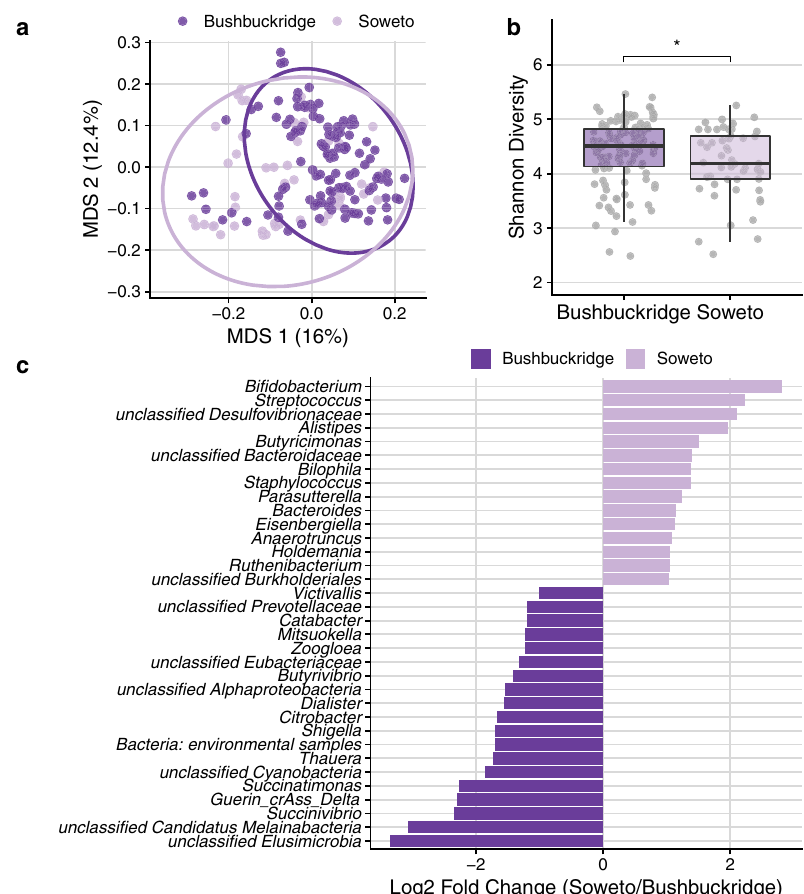
Fig. 2 Comparison of Bushbuckridge and Soweto microbiomes. a Multidimensional scaling (MDS) of pairwise Bray – Curtis distance between samples (rare fi ed to 1.44 M counts per sample to control for read depth and cumulative sum scaling normalized). Soweto samples have greater dispersion than Bushbuckridge (PERMDISP2 p < 0.001). b Shannon diversity calculated on rare fi ed species-level taxonomic classi fi cations for each sample (participant n = 118 Bushbuckridge, n = 51 Soweto). Samples from Bushbuckridge are higher in alpha diversity than samples from Soweto (two-sided Wilcoxon rank- sum test, p = 0.042). For box plots, lower and upper hinges correspond to the fi rst and third quartiles, upper and lower box plot whiskers represent the highest and lowest values within 1.5 times the interquartile range, and the horizontal line represents the median. c DESeq2 identi fi es microbial genera that are differentially abundant in rural Bushbuckridge compared to the urban Soweto cohort. Features with log2 fold change greater than one are plotted (full results in Supplementary Data